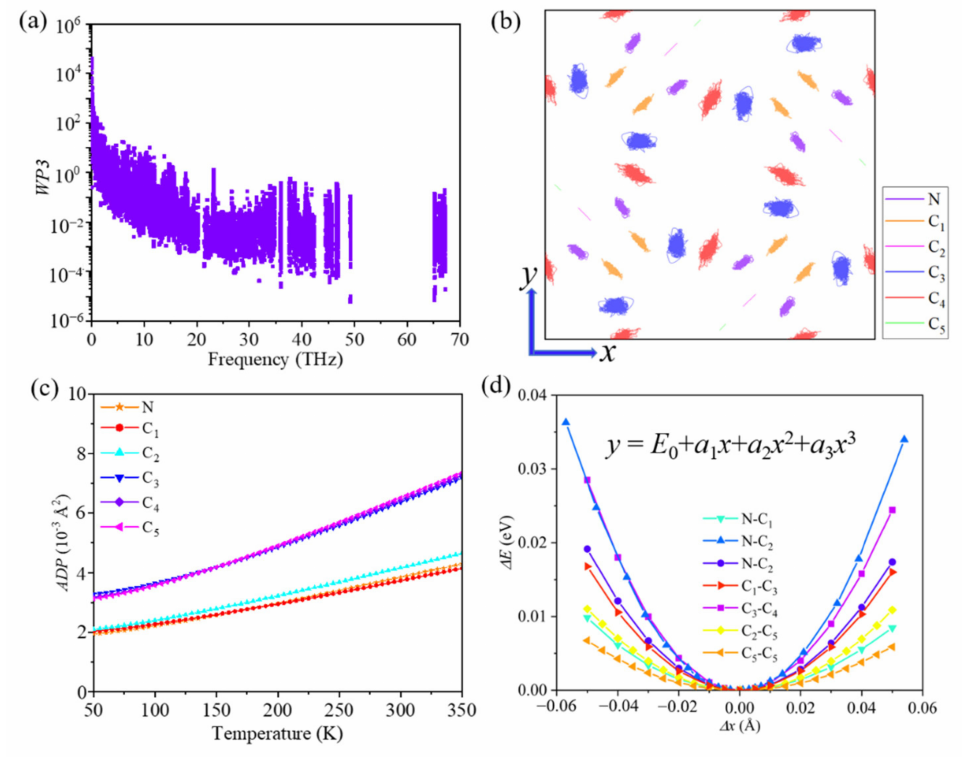
Figure 3. ( a ) Weighted phase space ( WP3 ), ( b ) trajectory of the atoms in the xy -plane from ab initio molecular dynamics simulations at 800 K, ( c ) atomic displacement parameter (ADP), and ( d ) bond energy curves of